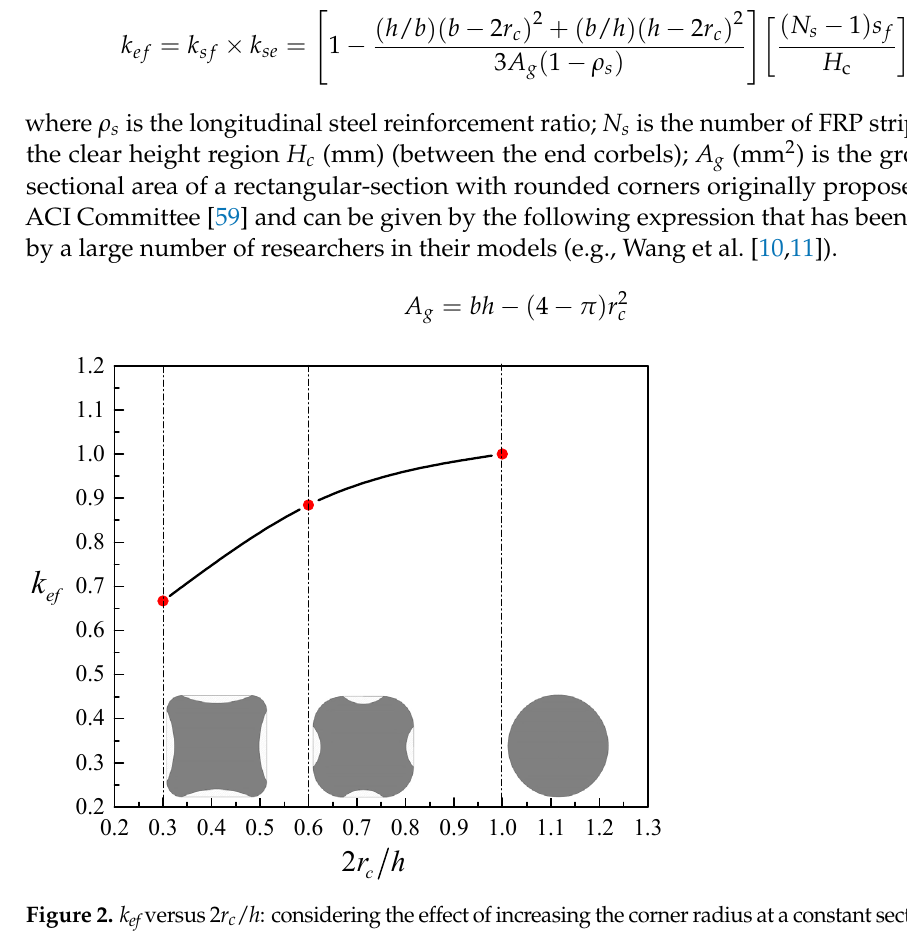
Figure 3. Relationship between different wrapping schemes by Yang et al. [22] and the proposed k ef . (